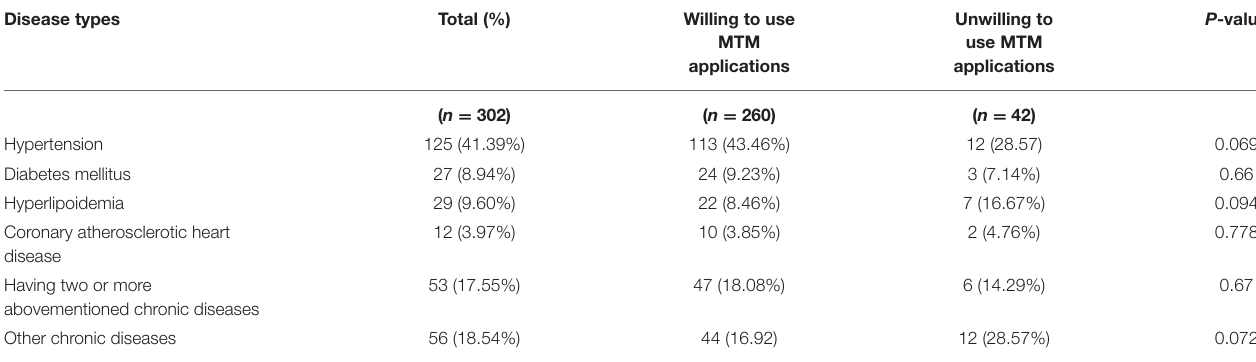
TABLE 1 | Chronic disease type of subjects.